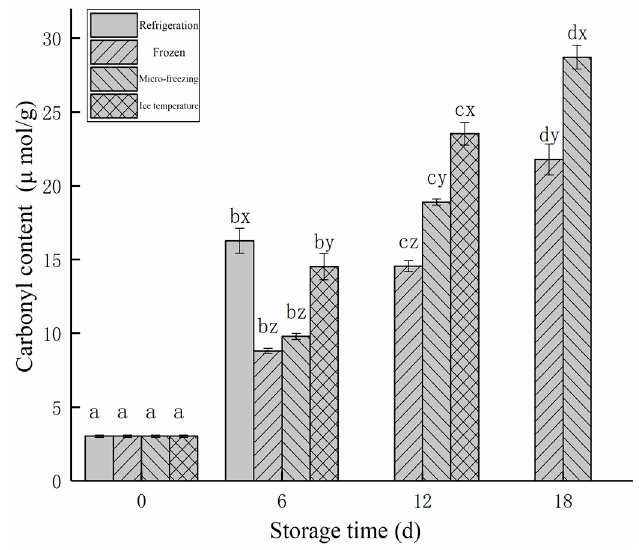
Figure 8. Changes of carbonyl content in beef stored in different low-temperature storage methods. d, day.